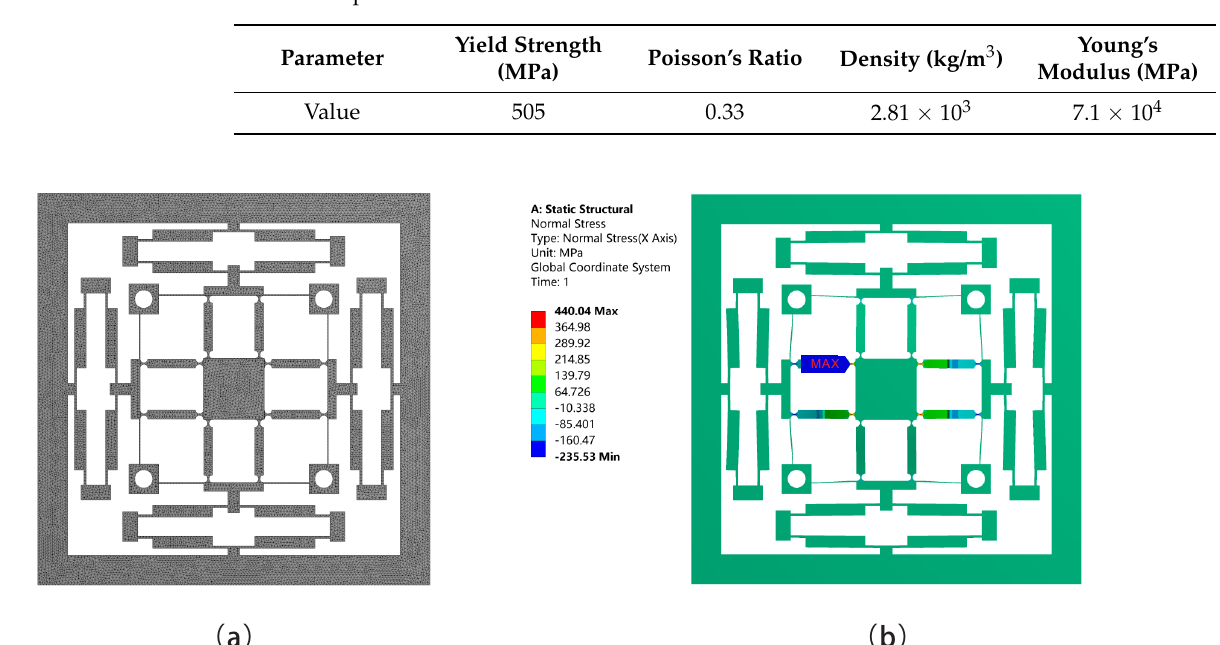
Figure 10. Meshing method and maximum stress: ( a ) meshing method of the platform; ( b ) the maximum